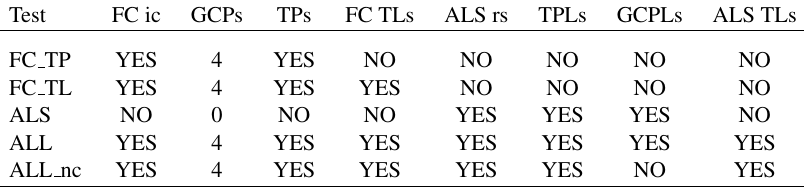
Table 6: Observations of block configurations.